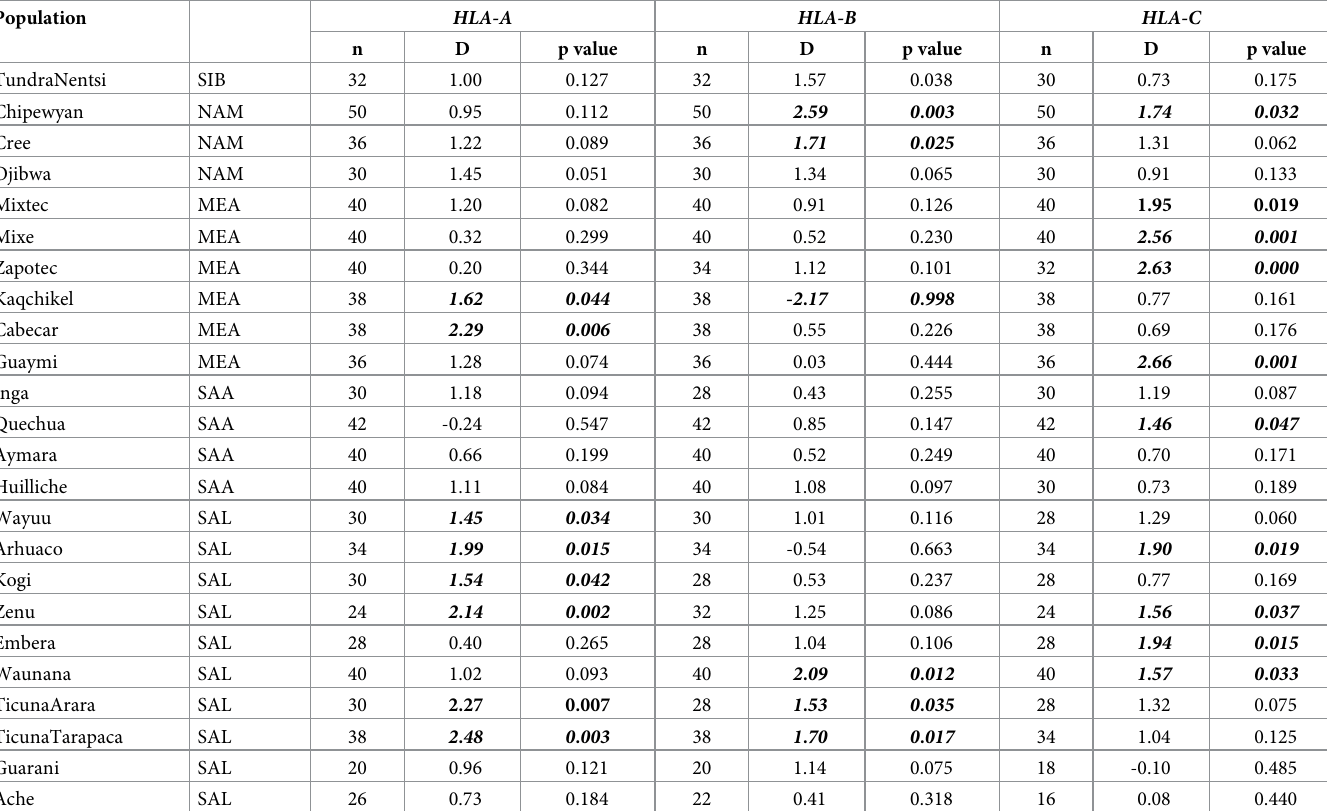
Table 4. Tajima’s D neutrality test for molecular-level data a .